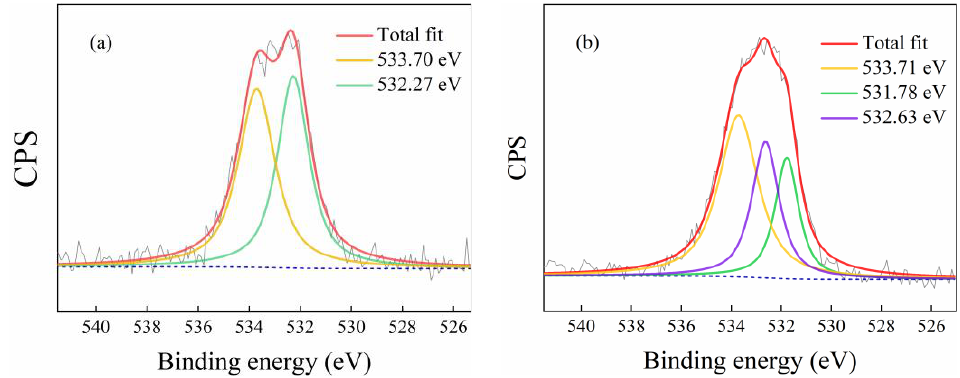
Figure 5. XPS survey spectra of n-PAN ( a ) and n-hemin/PAN ( b ).